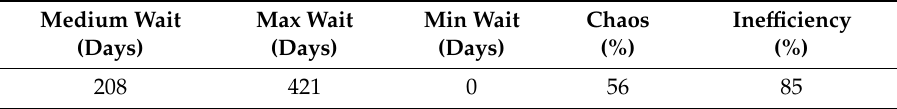
Table 1. Parameters of the Infant Neuropsychiatry